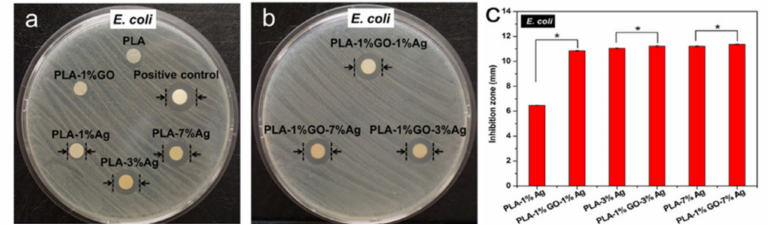
Figure 7. Photographs of agar plates cultivated with E. coli and treated with ( a ) PLA, PLA-1%GO, PLA-1%Ag, PLA-3%Ag, PLA-7%Ag, and positive control samples, and ( b ) PLA-1%GO-1%Ag, PLA-1%GO-3%Ag, PLA-1%GO-7%Ag hybrid fibrous mats. ( c ) Antibacterial inhibition zone values determined from ( a ) and ( b ) for the PLA-Ag and PLA-1%GO-Ag nanocomposite fibrous materials. Reprinted with permission from ref. [85]. Copyright 2017